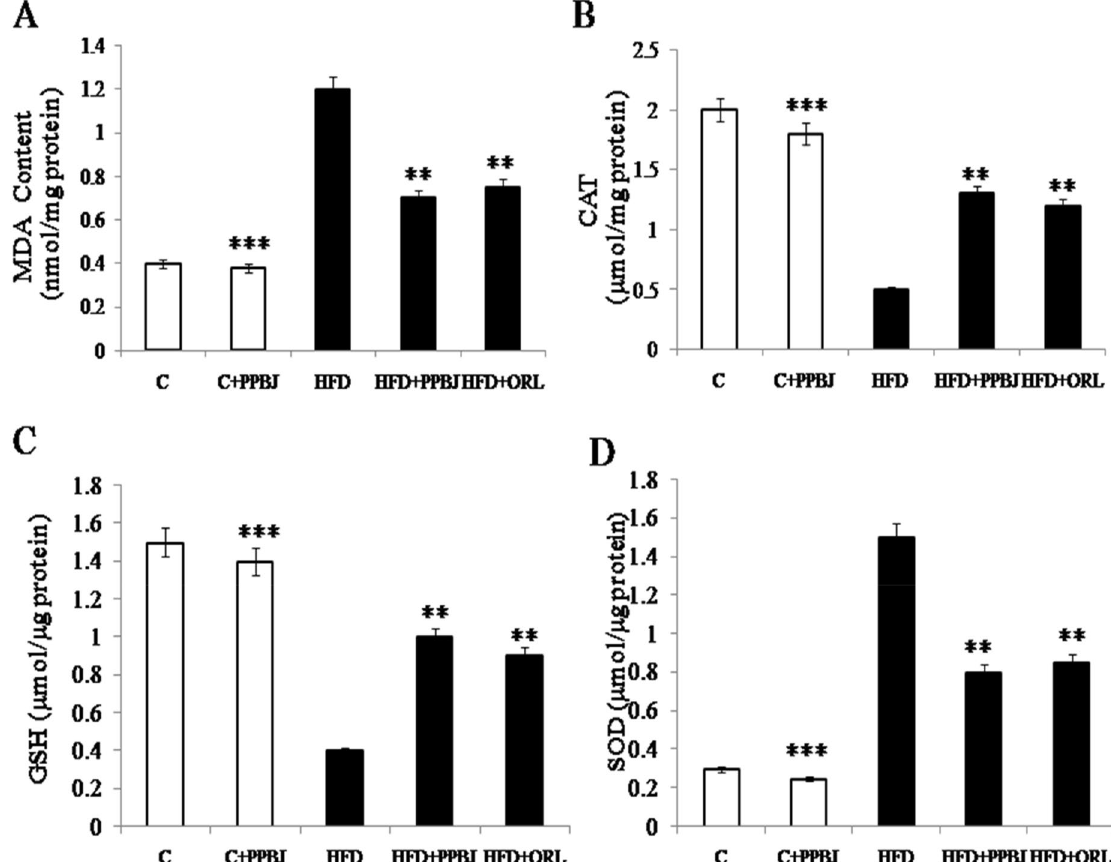
Figure 7. Effect of PPBJ on liver Lipid peroxidation. ( A ) MDA content. ( B ) CAT. ( C ) GSH and ( D ) SOD. MDA malondialdehyde; CAT catalase; GSH reduced glutathione; SOD superoxide dismutase. Data was presented as mean ± SEM (n = 6 each group). Statistically significance compared to their respective controls ***p < 0.001; **p < 0.01; *p < 0.05 . Groups compared using one way